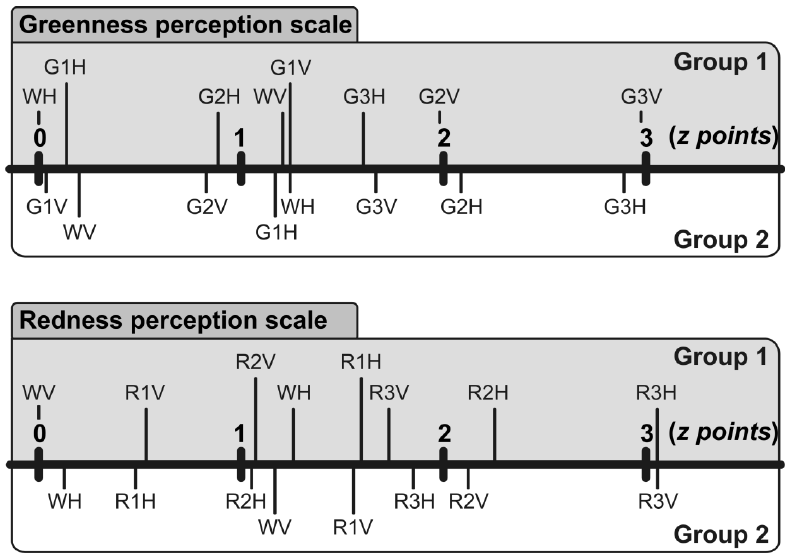
Figure 4. Positions (z points) of grating patterns from the red and the green series on the perceptual scale of both greenness (upper plot) and redness (lower plot), separately for each neural adaptation (Gray field: Group 1—Green-and-black horizontal gratings; White field: Group 2—Green-and-black vertical gratings). Each pattern is identified by a label indicating its background color (e.g., W stands for White, G1 for Green 1, R3 for Red 3, and so on) and grating orientation (e.g., H stands for Horizontal and V for